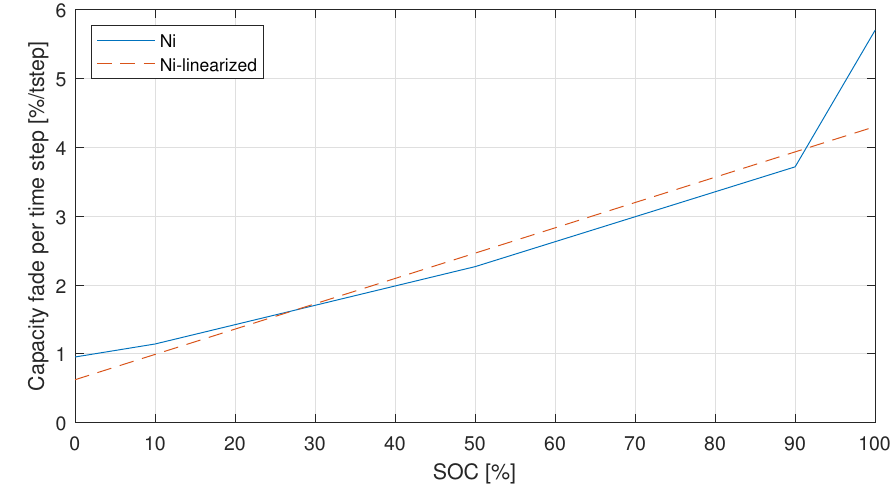
Figure 4. Calendric-Linearization ( t = 10